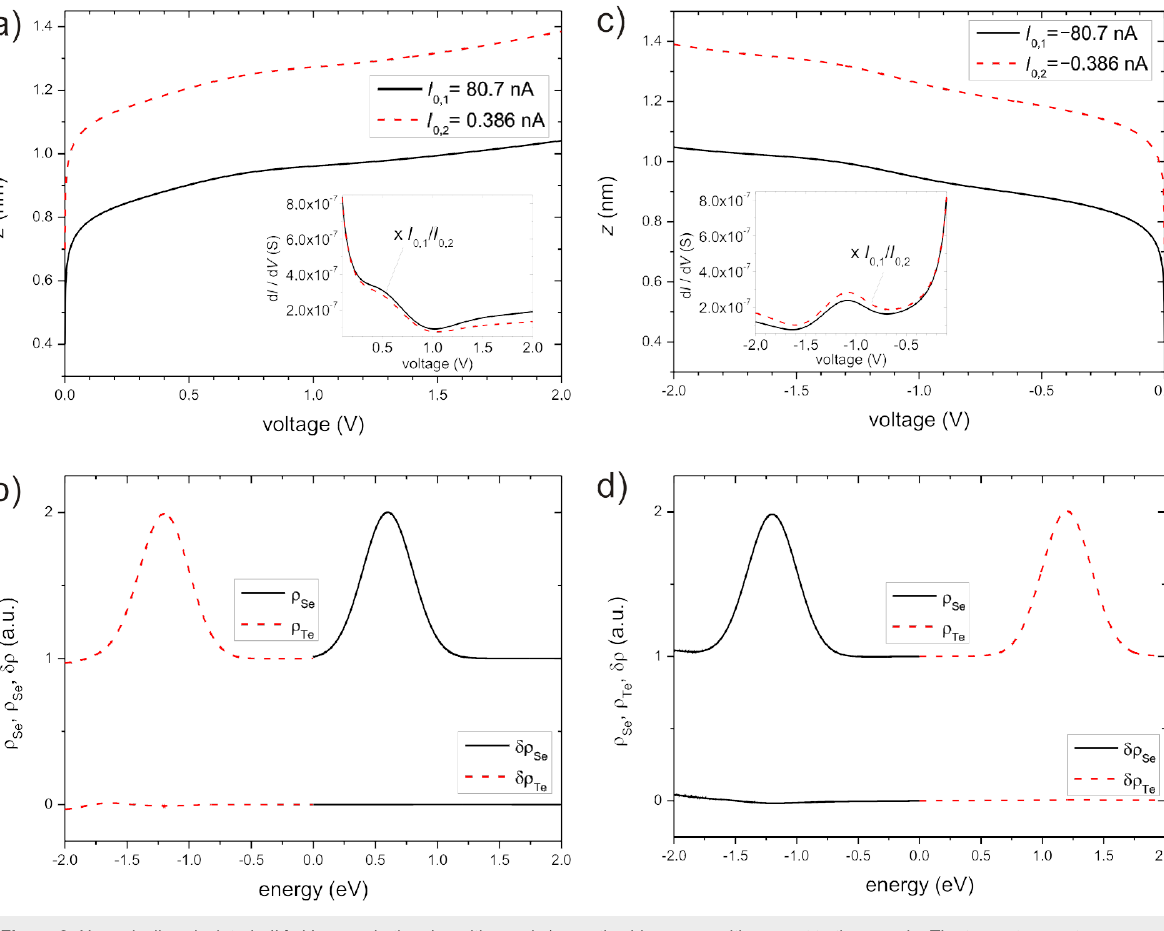
Figure 2: Numerically calculated z ( V )– V curves in the a) positive and c) negative bias range with respect to the sample. The two set currents are a) I 0,1 = 80.7 nA and I 0,2 = 0.386 nA and c) I 0,1 = − 80.7 nA and I 0,2 = − 0.386 nA. The inset displays the corresponding ∂ V I – V curves. For better com- parison, the ∂ V I – V curve for I 0,2 has been scaled by I 0,1 / I 0,2 . b) and d) are the corresponding recovered and deconvolved DOS for the positive and negative bias range, respectively, together with the errors ( δ ) relative to the model DOS (upper curves, ρ Se : black solid, ρ Te : red dashed; lower curves, δρ Se : black solid, δρ Te : red dashed). The values of the set currents result from the particular choice of the tip–sample separation at zero